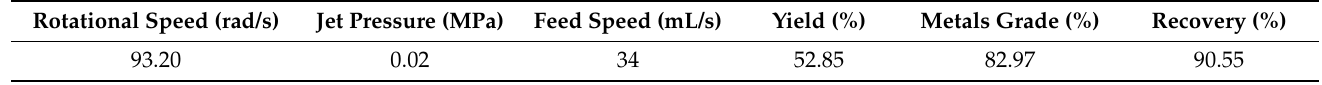
Table 4. The results of enhanced gravity separation under optimal conditions.